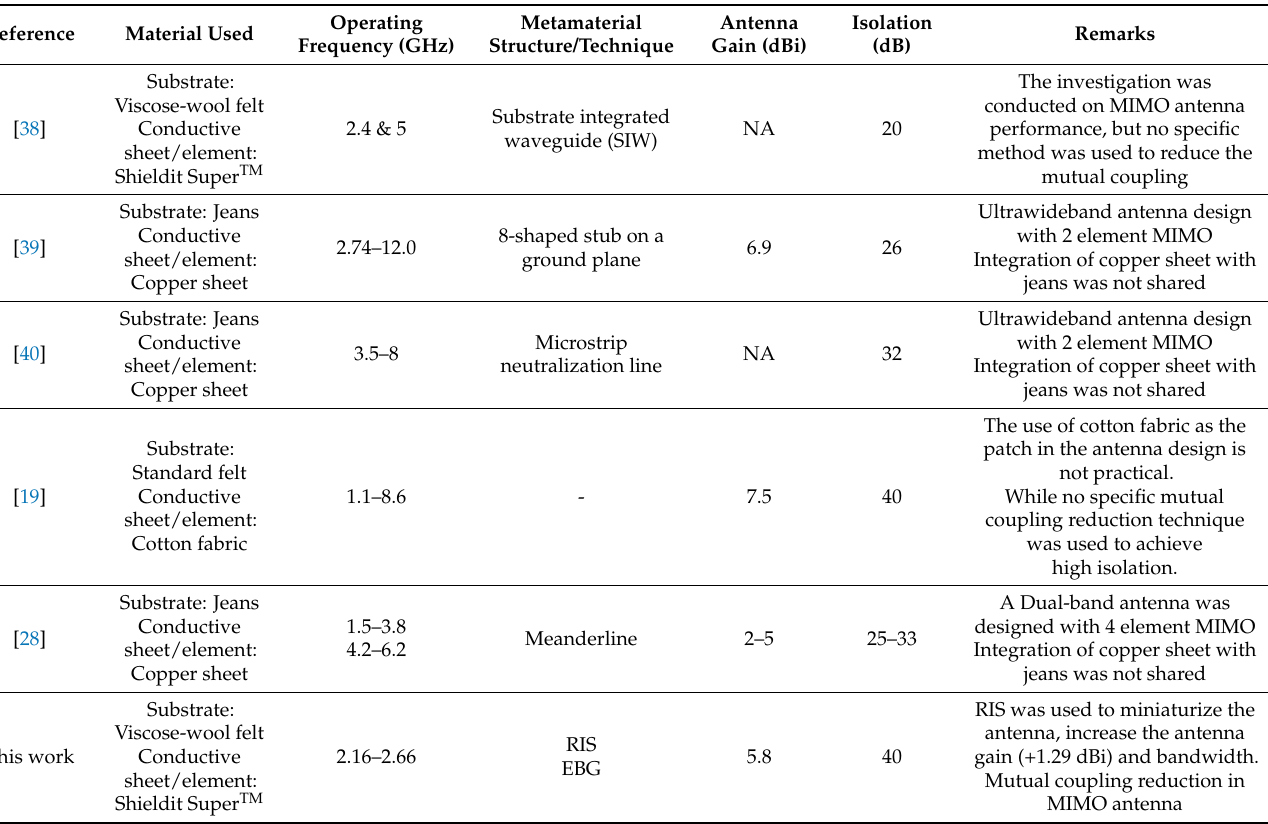
Table 3. Comparison of the proposed design with relevant previous work in the